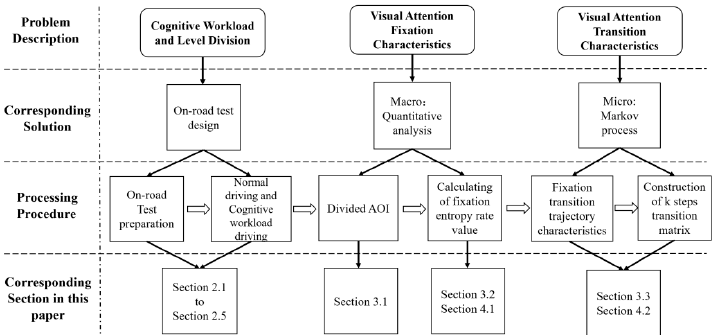
Figure 1. Research framework.